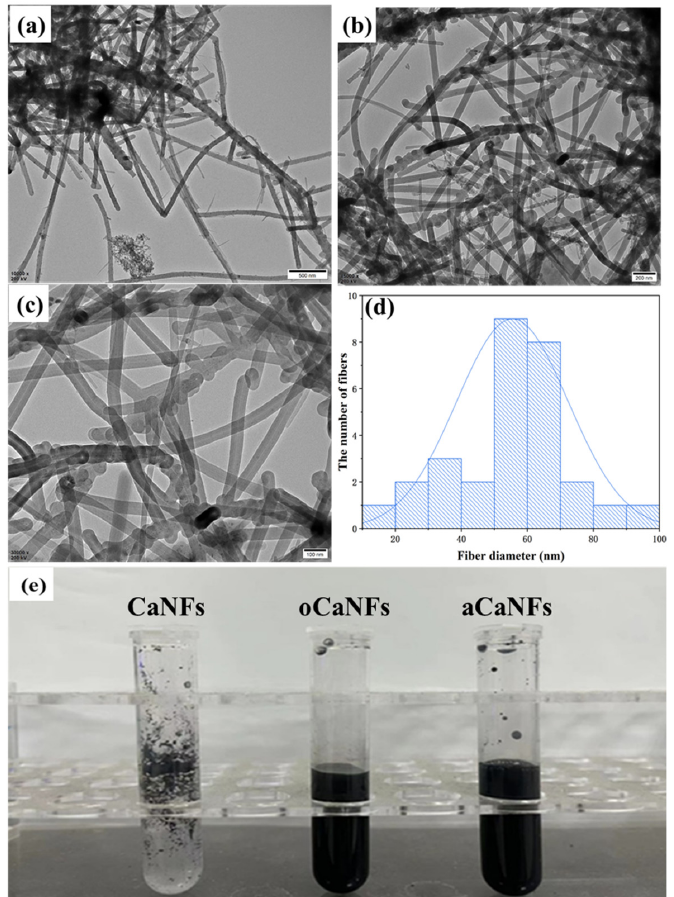
Figure 3. TEM characterizations of ( a ) CaNFs, ( b ) oCaNFs, and ( c ) aCaNFs. The diameter distribution of CaNFs is shown in image ( d ). ( e ) Photographs of chemically modified CaNFs.